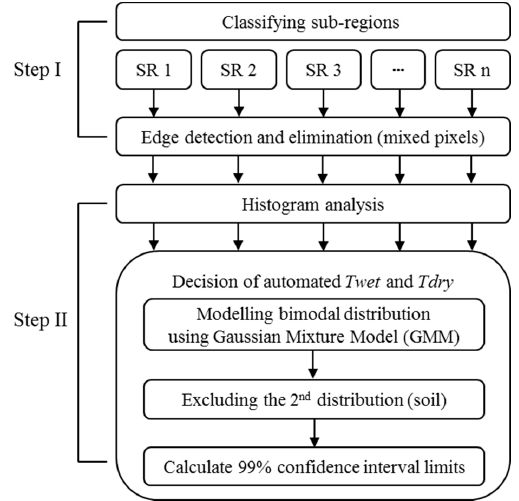
Figure 4 . Flow chart of the decision of adaptive reference temperatures based on sub-regions (SR). The histograms feature distinctive bimodal and normal density distributions, representing vegetated pixels and soil pixels. The temperature differences of the two features are obvious, corresponding to a range of 30–35 °C at midday. The Gaussian mixture modelling (GMM) is fit to the temperature distribution to objectively cluster canopy/soil pixels and to estimate representative T wet and T dry values for canopy. The GMM assigns each observation to a cluster by maximizing the posterior probability, and is composed of k multivariate normal density components, where k is the number of clusters (e.g., k = 2 for bimodal distribution). The higher-temperature component of Gaussian distribution, representing non-canopy pixels, is eliminated to exclude soil background effects in the Gaussian distribution. Then, an automated threshold of T wet and T dry for each sub-region is determined by the critical values of 99% confidence interval limits from the lower-temperature component of Gaussian distribution.